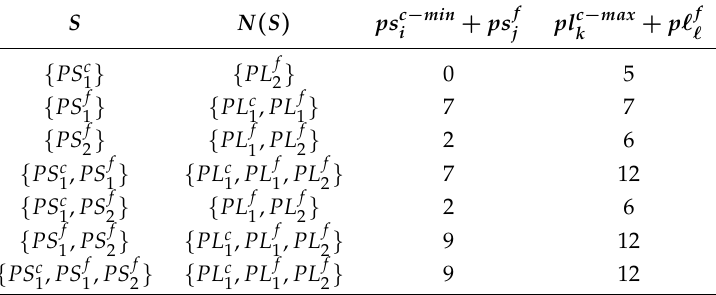
Table 1. List of subset S of